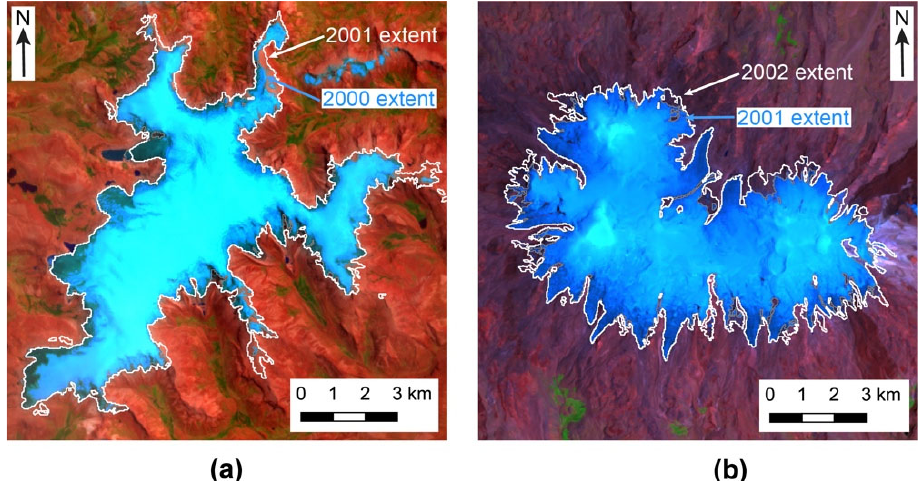
Figure A2. Comparison between estimated glacial extents of two adjacent years at ( a ) the Quelccaya Ice Cap and ( b ) Nevado Coropuna. The glacial extent for the younger year is anomalously large, and it was excluded from the linear regression analysis.